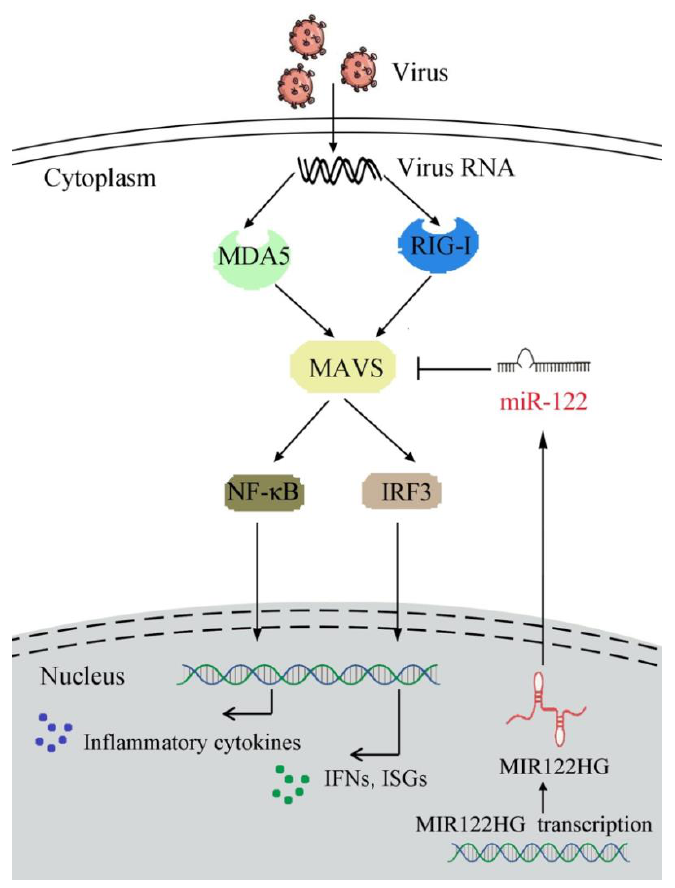
Figure 7. A mechanism model of MAVS regulatory functions and networks. Fish MAVS could induce the innate antiviral immune response by recruiting NF- κ B and IRF3 to trigger inflammatory cytokines and the activation of antiviral factors upon SCRV treatment. MIR122HG regulates the release of miR-122 and acts as the precursor of miR-122 to indirectly inhibit MAVS expression and negatively regulates MAVS-mediated NF- κB and IRF3 signaling, which may promote the virus escape.